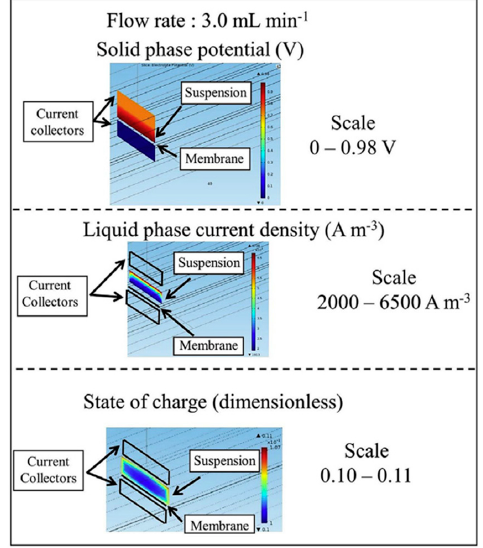
Figure 3. Model of the SSFB with a LTO-based suspension at a current density of 0.34 mA cm − 2 and a 10% state of charge. The results of liquid phase current density, solid phase potential, and state of charge were shown in the form of a two-dimensional section [37] .